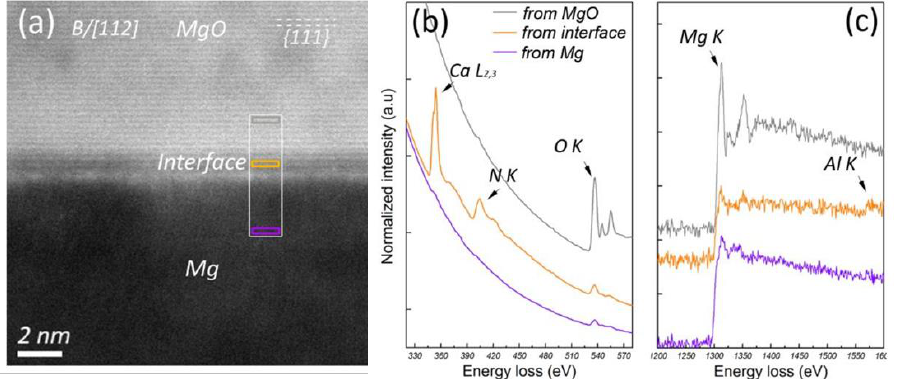
Figure 30. Ca segregation at Mg/(1 1 1)MgO interface [29,77]. ( a ) STEM-HAADF image of interface between Mg and MgO, showing a segregation layer at the interface; ( b , c ) EELS spectra acquired from different areas across the interface as indicated in the HAADF image.